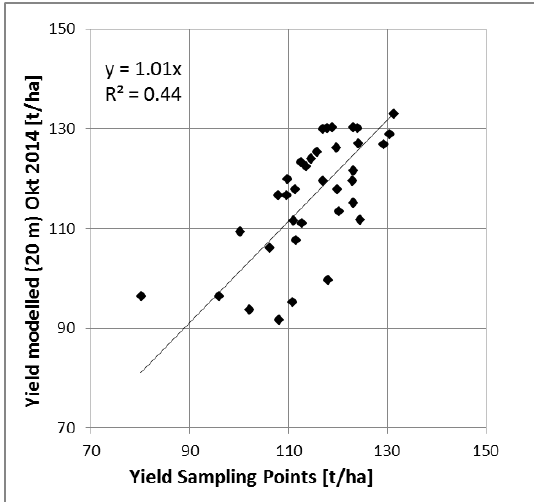
Figure 10: Yield validation sampling points -